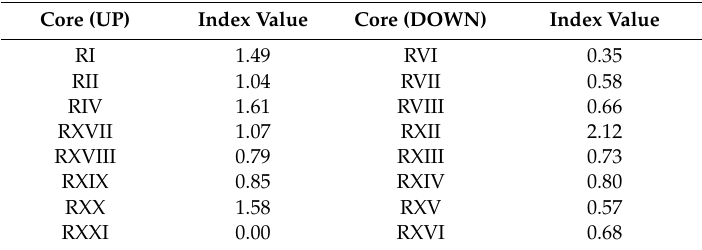
Table 2. Shannon (H ′ ) diversity index value in investigated sediment cores. (UP — subsidence ponds formed after the closure of the mine; DOWN—subsidence ponds created during the peak of Zn and Pb ore exploitation).